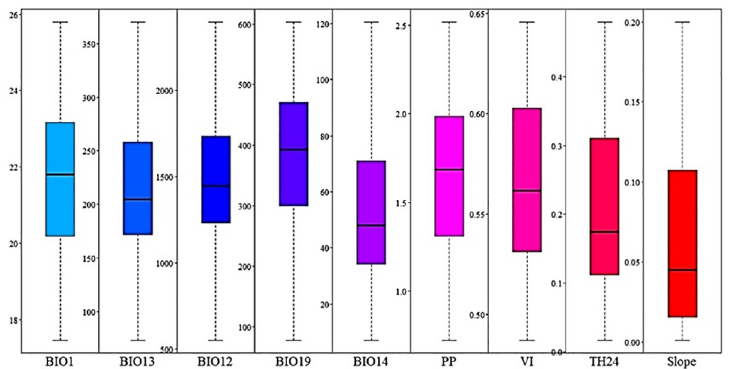
Fig 6. Estimate of an optimum niche for the establishment of Diatraea spp. In the model, quartiles indicate areas with environmental conditions favorable for development of Diatraea spp., with those under 50% representing optimum